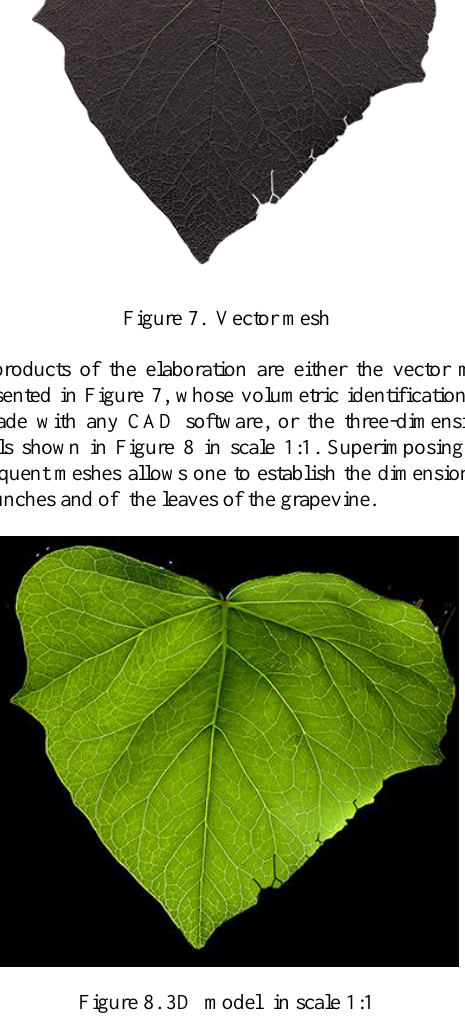
Figure 8. 3D model in scale